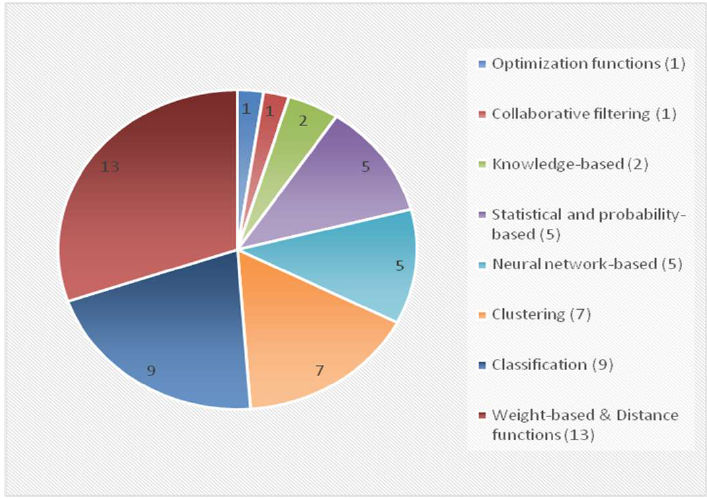
Figure 6. Approaches on content-based analysis and text mining.